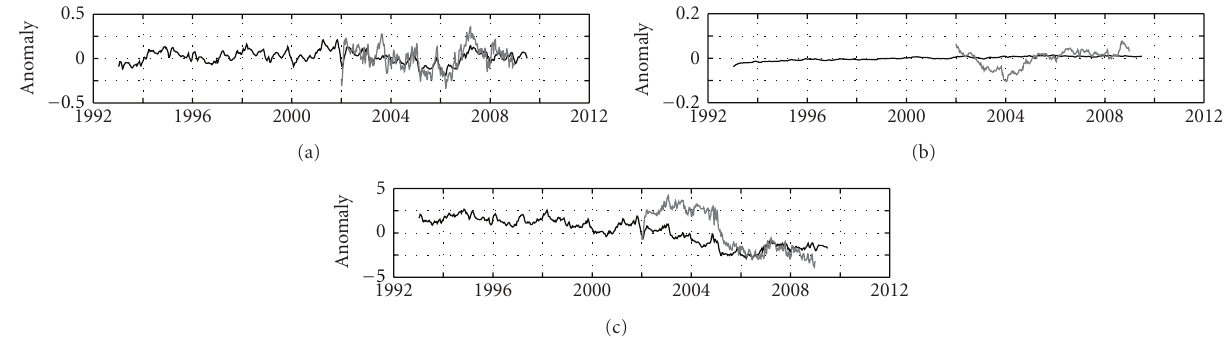
Figure 3: Mediterranean-averaged temperature panel (a), salinity panel (b), and steric sea level panel (c) anomalies for the entire water column from ECCO (black line) and GLORYS (gray line) model data.